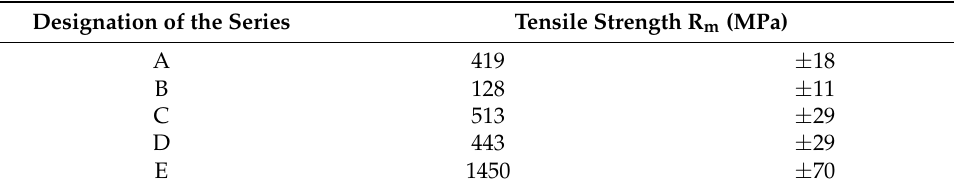
Table 10. Tensile strength R m of composite laminates, reprinted from [31]. Designation of the Series